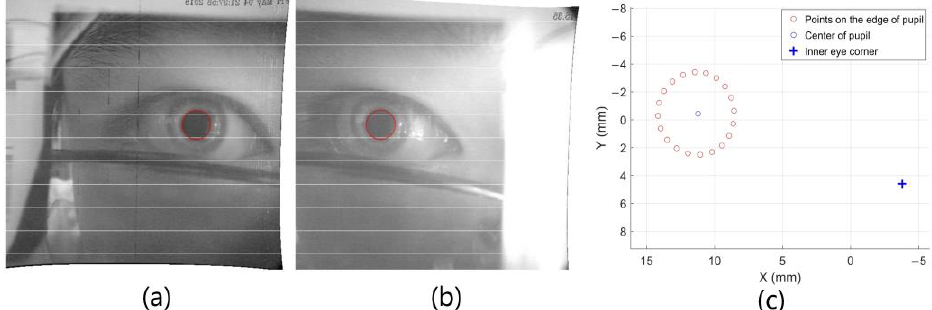
Figure 7. ( a , b ) represent the images of binocular cameras after epipolar rectification; and ( c ) represents the detected pupil and inner eye corner.